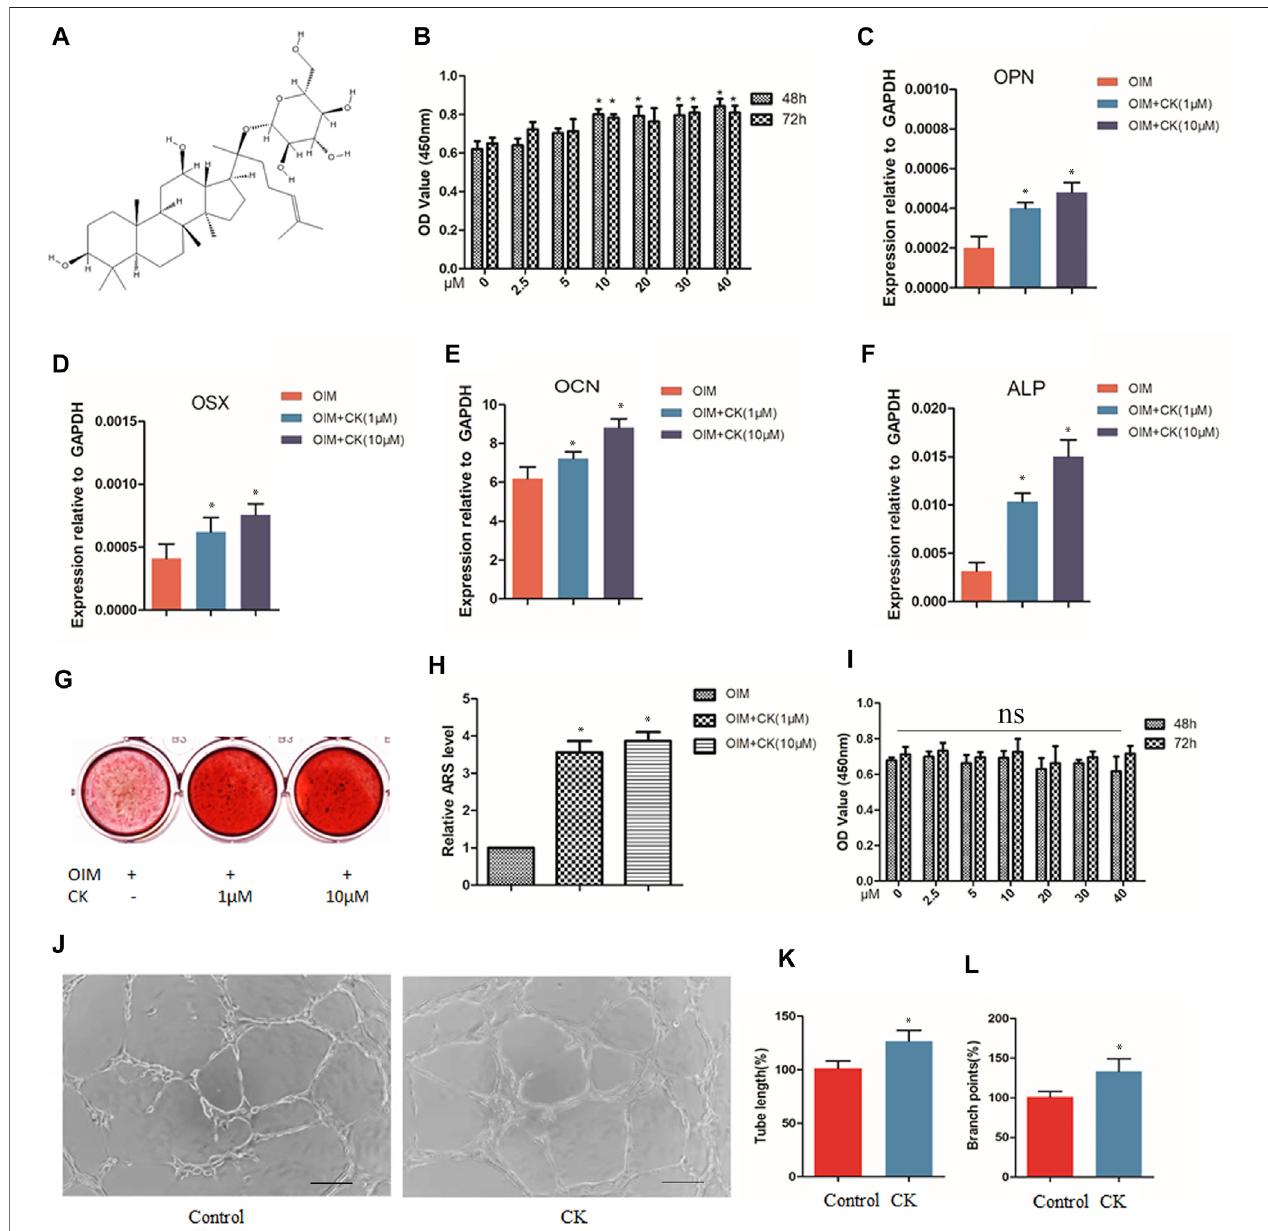
FIGURE1| CKenhancedcellviability,osteogenesisandangiogenesis invitro . (A) ThechemicalstructuredepictionofCK. (B) Opticaldensity(OD)valuesindicating the effects of CK treatment for 48 h and 72h on cell viability of BMSCs, * p < 0.05, n = 3, compared with 0 μ M CK group. (C – F) Real-time PCR results of osteogenesis- related genes at 3 days treated with different concentrations of CK in OIM, * p < 0.05, n = 3, compared with OIM group. (G) Representative staining images and (H) Quanti fi cation of Alizarin Red Sof BMSCs incubated with different concentrations ofCK in OIM for 14 days, * p < 0.05, n = 3, compared with OIM group. (I) Optical density(OD)valuesindicatingtheeffectsofCKtreatmentfor48hand72honcellviabilityofHUVECs,* p < 0.05, n =3,comparedwith0 μ MCKgroup. (J) Representative imagesoftube formationassay and (K-L) Quantitative analysisoftube lengthand branchpoints in Matrigel MSCs and HUVEC co-culture system, Scale bars < 100 μ m, * p < 0.05, compared with the Control group, n =